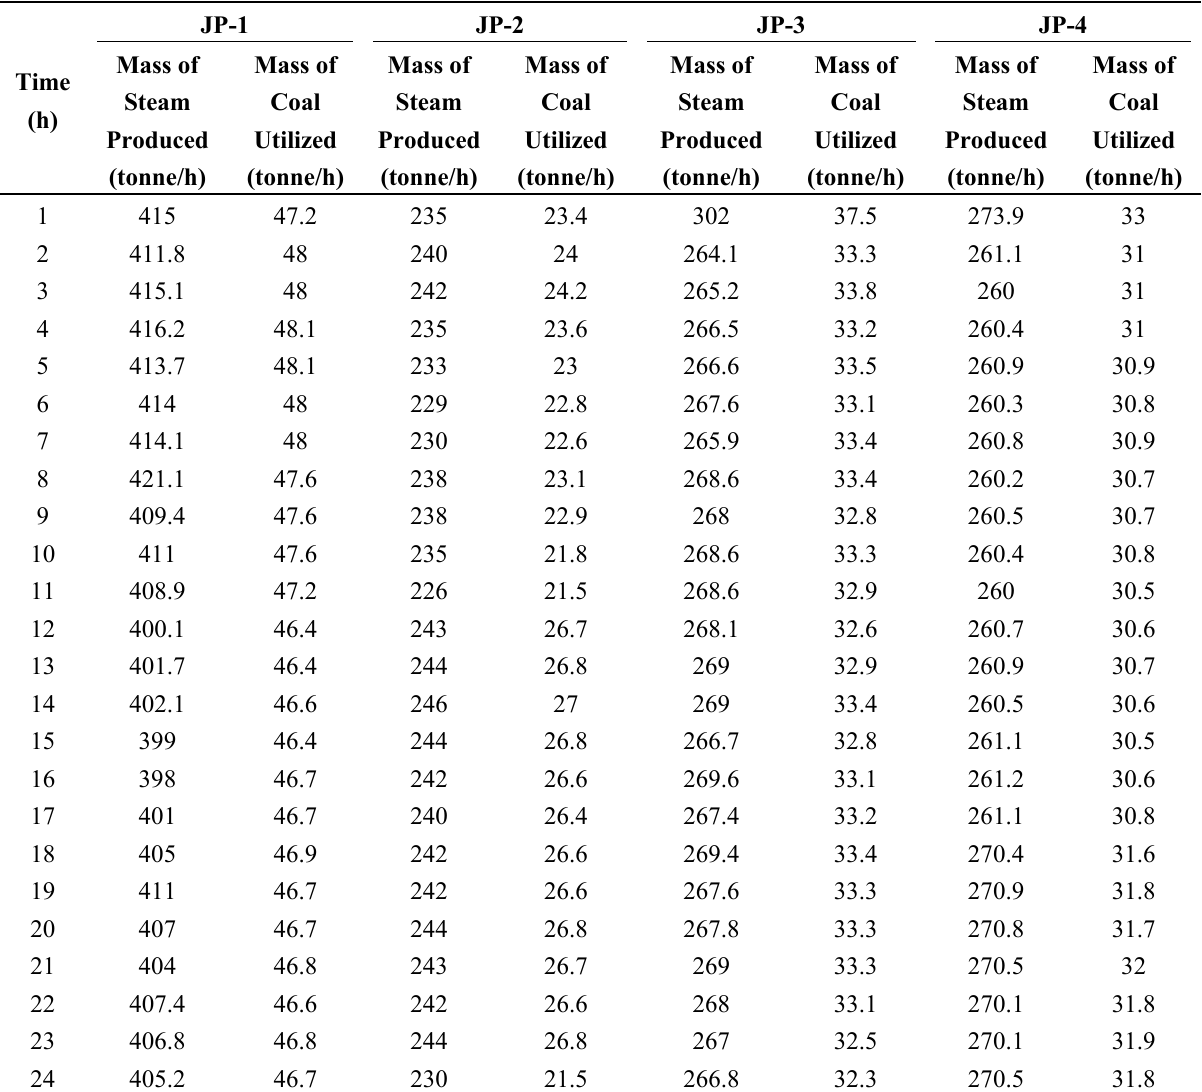
Table 1. Actual masses of coal utilized and steam produced for the four in-plant boilers.